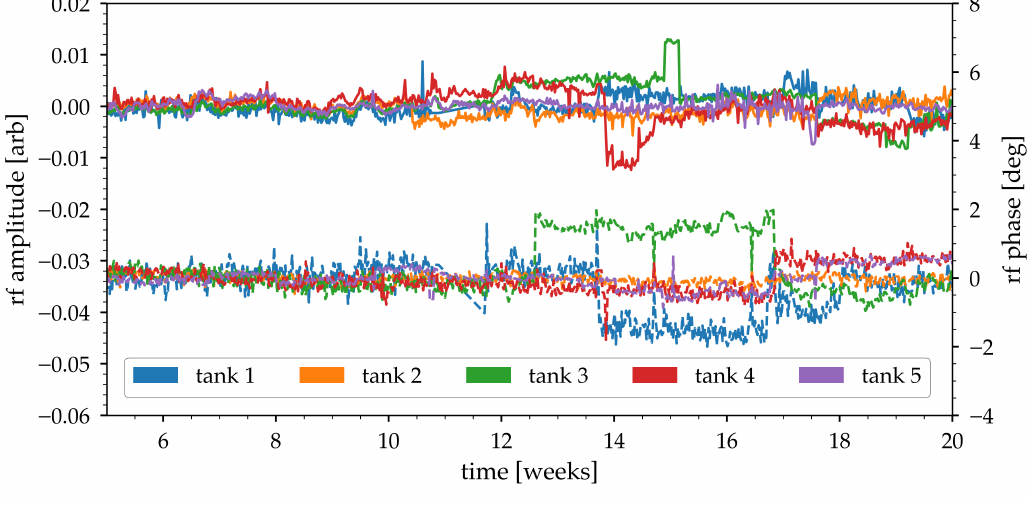
Figure 6. RF amplitude (solid lines) and phase (dashed lines) for each of the five DTL tanks during the 15 week period of interest. For each parameter the median has been subtracted to better illustrate the change in the parameters over time. Figure 7 shows the toroid measurements at the exit of the DTL tanks over the whole 20 week